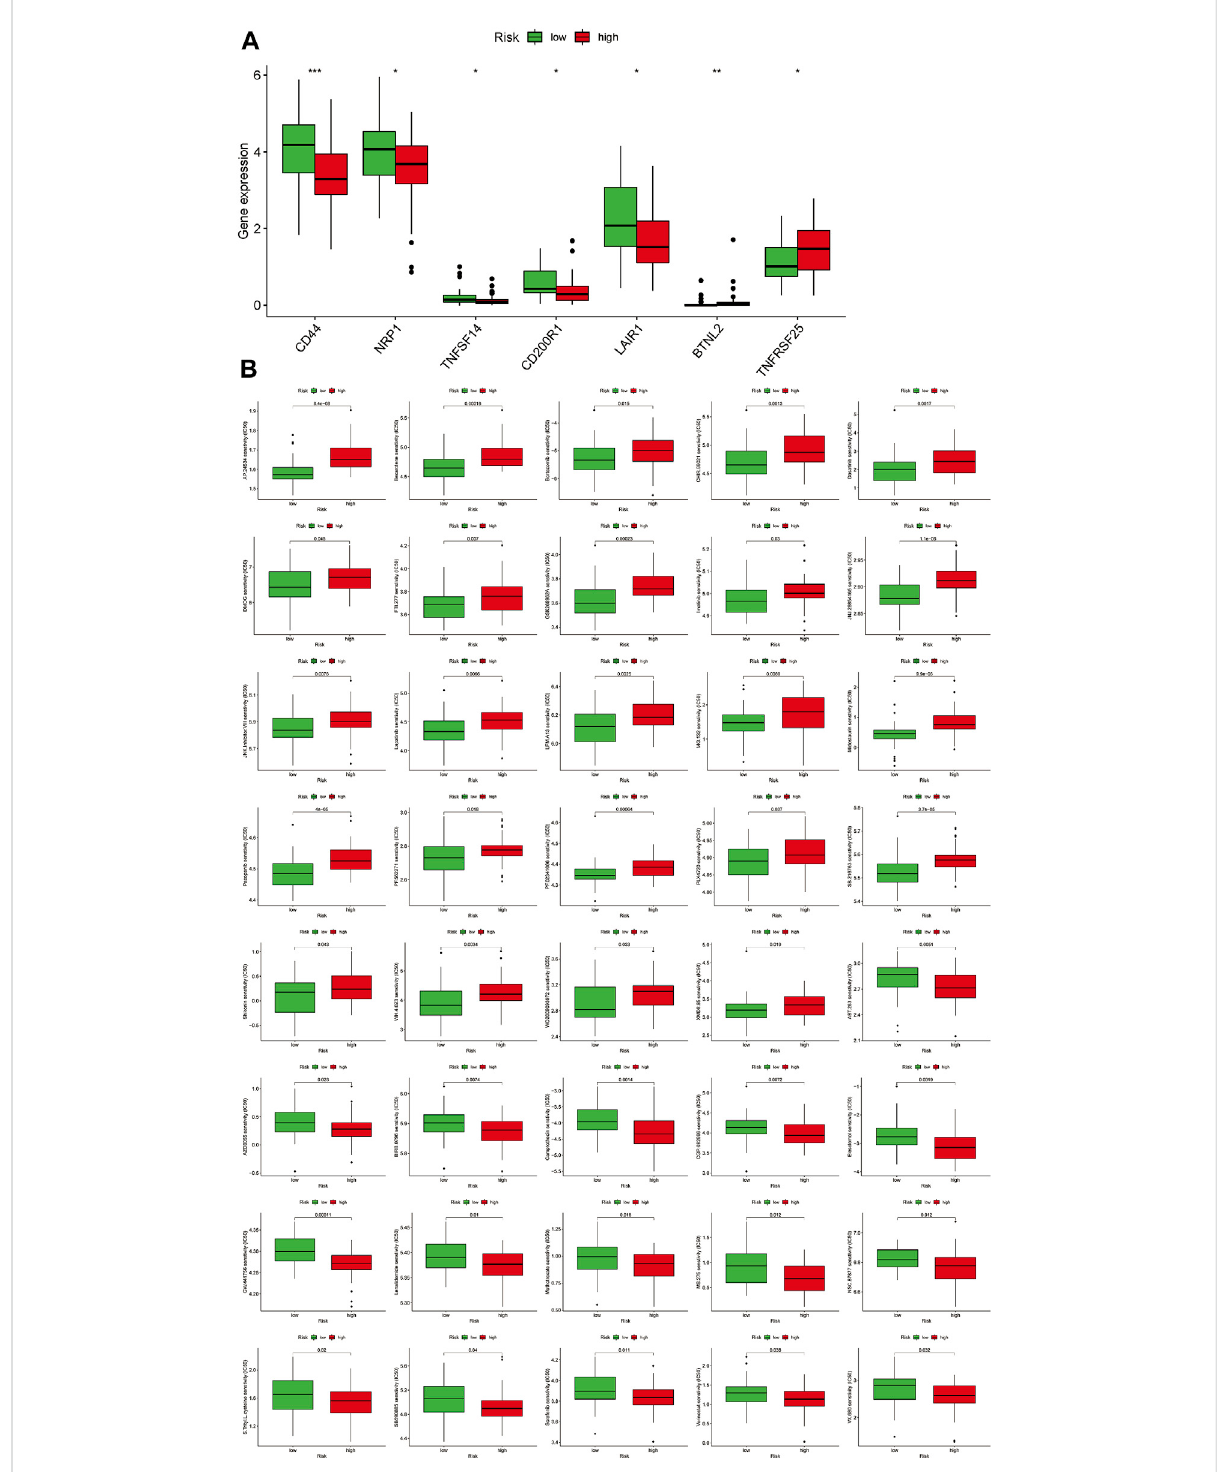
Predict thebest immune checkpoint inhibitors and drugs for two risk groups. (A) The expression of immune checkpoints in thetworisk groups. (B) The difference of sensitivity of drugs between high-risk and low-risk